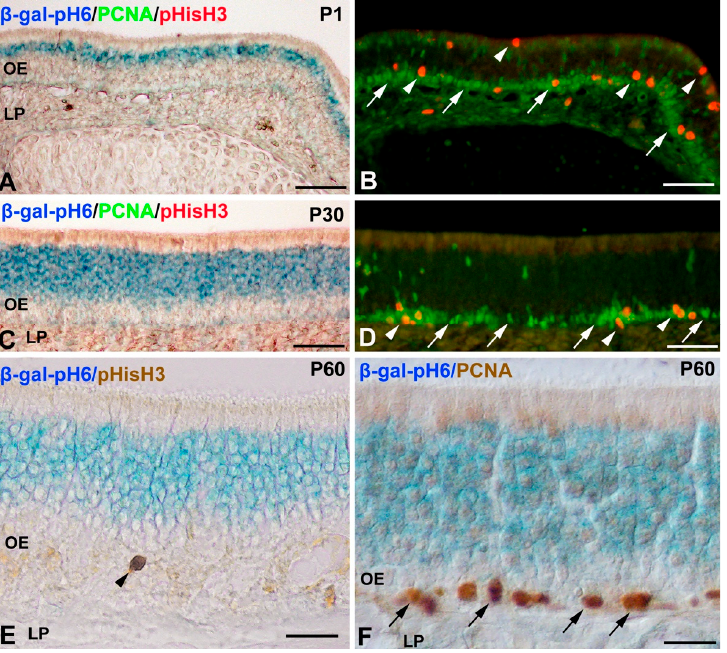
Figure 3. Relationship between β -gal-pH6 histochemical staining and markers of proliferation in the olfactory epithelium of mice of different postnatal ages. Cryosections were triply labeled with β -gal-pH6 histochemistry and PCNA/pHisH3 antibodies ( A – D ) or doubly labeled with β -gal-pH6 histochemistry and antibodies against pHisH3 ( E ) or antibodies against PCNA ( F ). ( A , B ) At P0, PCNA immunoreactive nuclei (green, arrows) and pHisH3 immunolabeled mitoses (red, arrowheads) were mainly located in the basal and apical regions of the olfactory epithelium. A band of β -gal- pH6 staining was found in the epithelium region where the olfactory neurons were located. ( C – F ) At P30 and P60, a wide band of intense β -gal-pH6 labeling was found in the intermediate layer of the olfactory epithelium. PCNA immunoreactive nuclei (arrows) and pHisH3 immunolabeled mitoses (arrowheads) were mainly located in the basal region of the epithelium. Some PCNA- immunolabeled nuclei were found at different depths of the epithelium ( D ). LP, lamina propria; OE, olfactory epithelium. Scale bars: 100 µ m in ( A – D ); 50 µ m in ( E , F